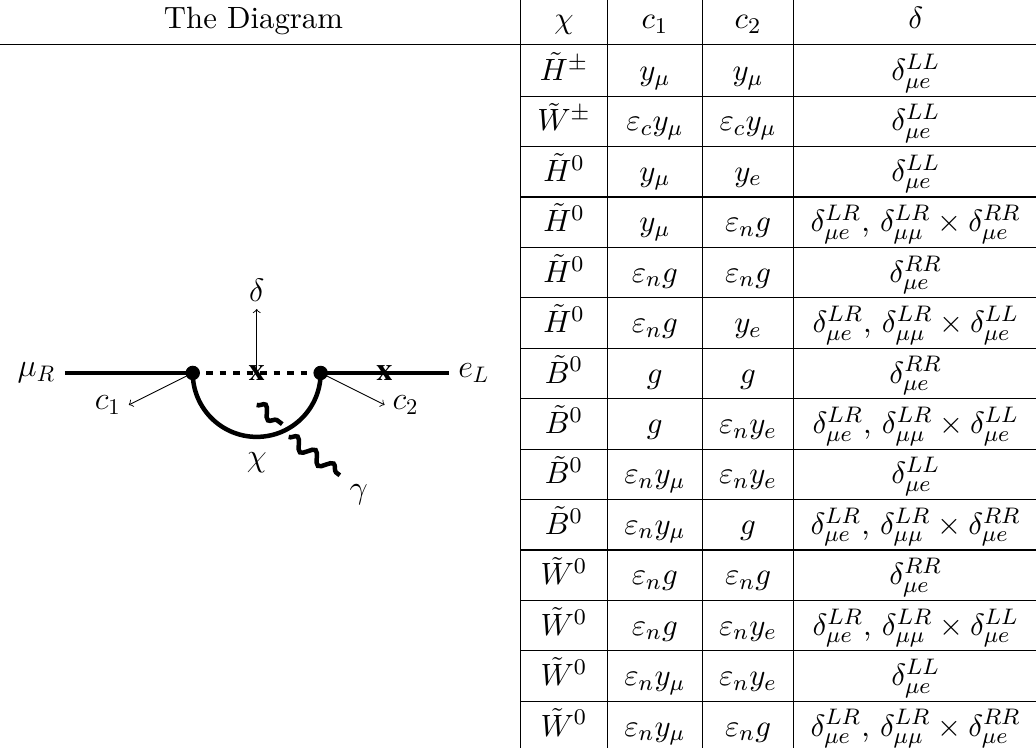
Table 6 . Diagrams with sleptons and gauginos/higgsinos in the loop contributing to c R from the y term in eq. (A.2). This Wilson coefficient contributes to LFV observables such as R y R BR ( µ → eγ ) . The general topology of the diagram is shown on left. The second column shows the gaugino or the higgsino in the loop. The SM couplings appearing in each vertex, as well as ε s that characterize neutralino or chargino mixings, are shown in the next two columns. We consider all possible combinations of couplings with all possible fermions and sleptons in the loop. The last column includes the δ insertions on the slepton propagator. We are only including diagrams with the fewest number of δ insertions and at most one δ LR entry. These δ insertions are the source of LFV in our setup. As evident from the table, the diagrams with a Bino in the loop and no chirality flip on the propagator dominates, while other diagrams have more suppression thanks to fermion mixings ε , the SM yukawas, or a δ LR insertion on the slepton n/c